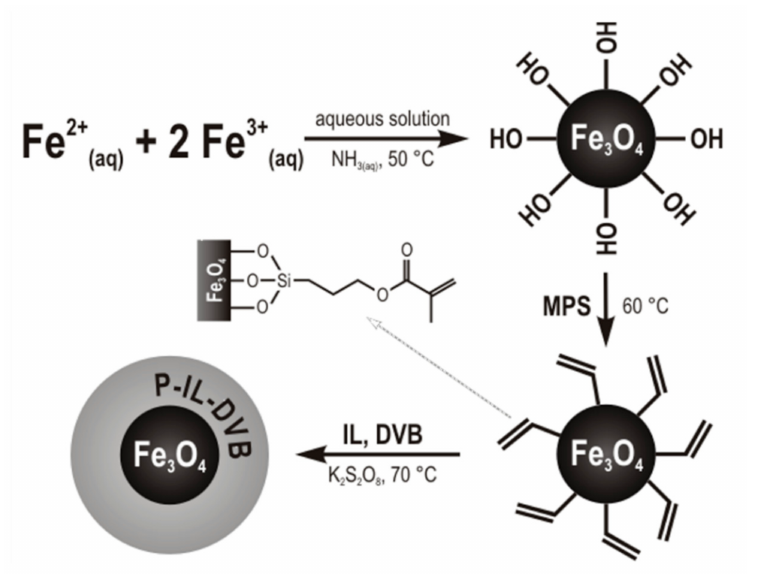
Figure 1. General scheme of synthesis of magnetic nanoparticles coated with crosslinked zwitterionic poly(ionic